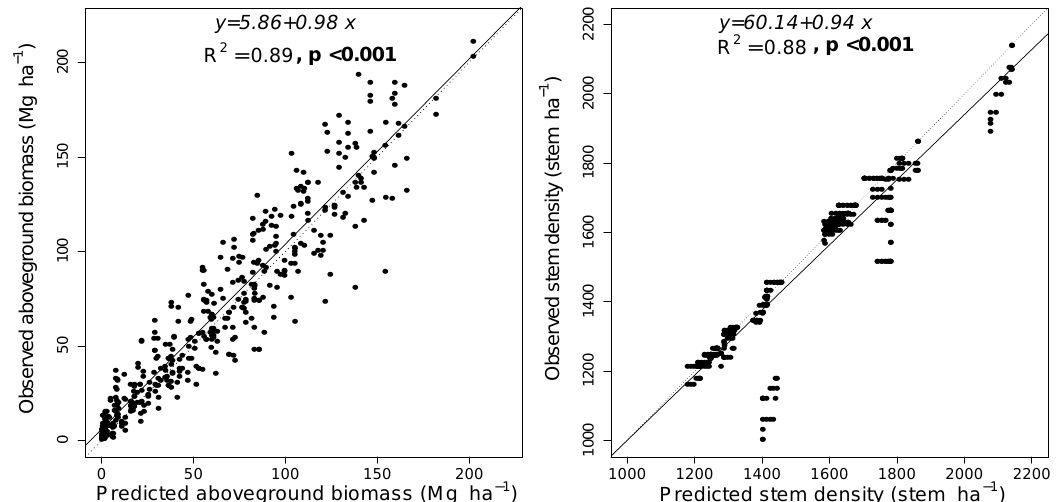
Figure 4. Relationship between observed aboveground biomass (Mg ha − 1 ) and modeled aboveground biomass (left) and measured stem density (stem ha − 1 ) and modeled stem density across the 48 control plots at the 21 study sites located across the southeastern United States. Solid lines represent linear fit between observed and predicted values and dotted lines represent the 1:1 line between observed and predicted values. Group of points around (1400,1000) in left diagram were due to lightning caused